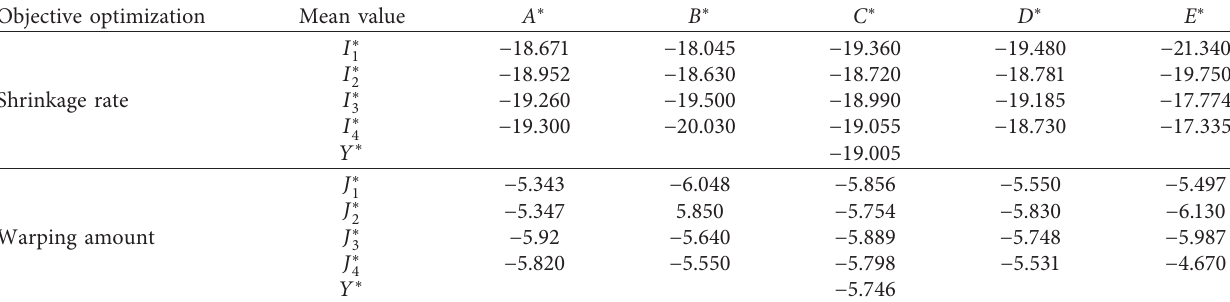
Table 4: Mean of SNR of shrinkage and warpage.